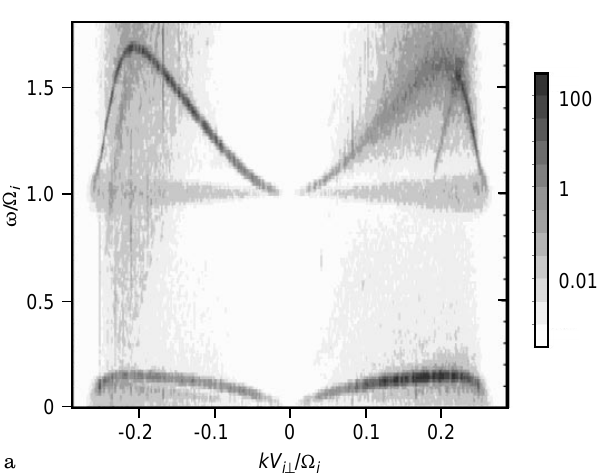
at frequencies below 0 : 2 (cid:88) i , and electrostatic ion cyclotron waves can be seen at frequencies above (cid:88) i . b Numerical solution of the dispersion relations. The 80 (cid:14) direction is marked with a solid line